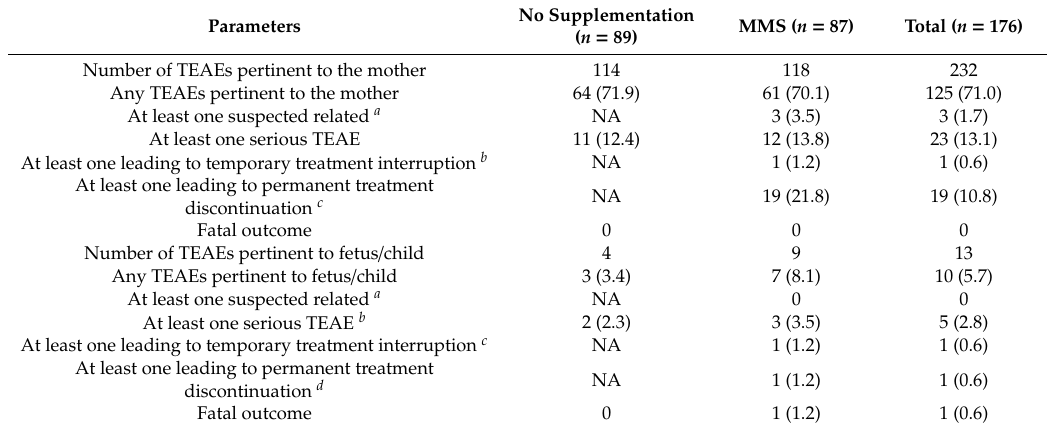
Table 3. Summary of participants with treatment-emergent adverse event (safety population; values expressed as n (%)